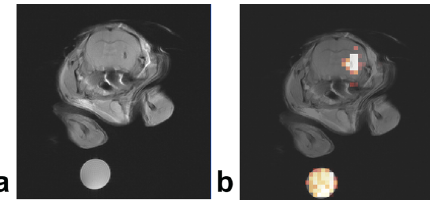
Figure 2. In vivo 19 F/ 1 H MRI of mouse glioma showing 19 F labeled tumor cells. Panel ( A ) is a 1 H axial image and panel ( B ) is a composite 19 F and 1 H image of PCE labeled GL261 glioma cells in the right striatum at day 5 post tumor inoculation. The 19 F image is rendered in a hot-iron intensity scale, and the 1 H is in gray scale. Unlabeled GL261 cells were injected into the contralateral striatum in the same imaging plane. Diluted PCE emulsion (9.8 mg/ml) in 2% agarose was used as a 19 F reference (shown at bottom). doi:10.1371/journal.pone.0059479.g002 19 F ‘hot-spot’ image. No 19 F signal was detected on the contralateral side of the striatum inoculated with unlabeled cells.